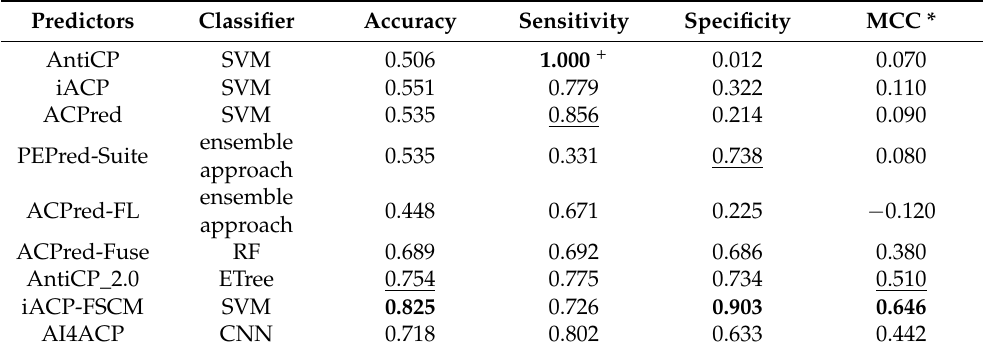
Table 2. Comparison of ACP predictors trained and tested with the main data set. Results were